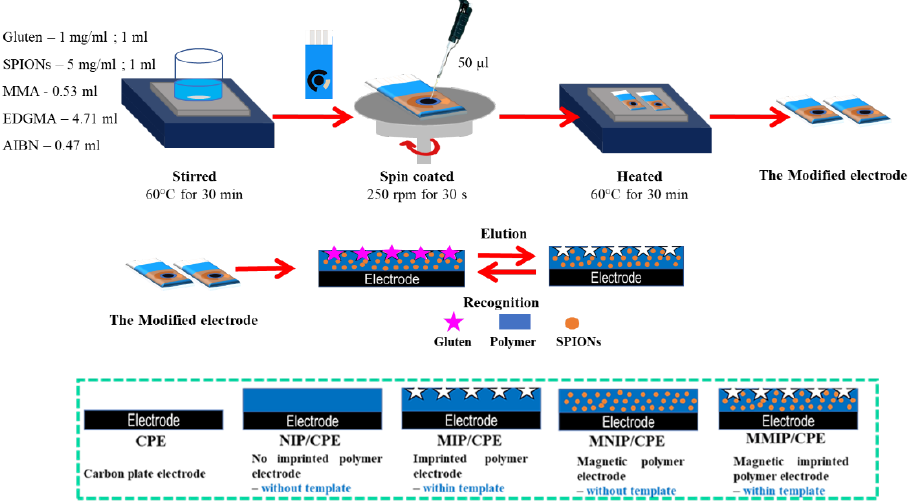
Figure 1. Schematic diagram of the MMIP – gluten electrode preparation and modeled electrode surface modification.